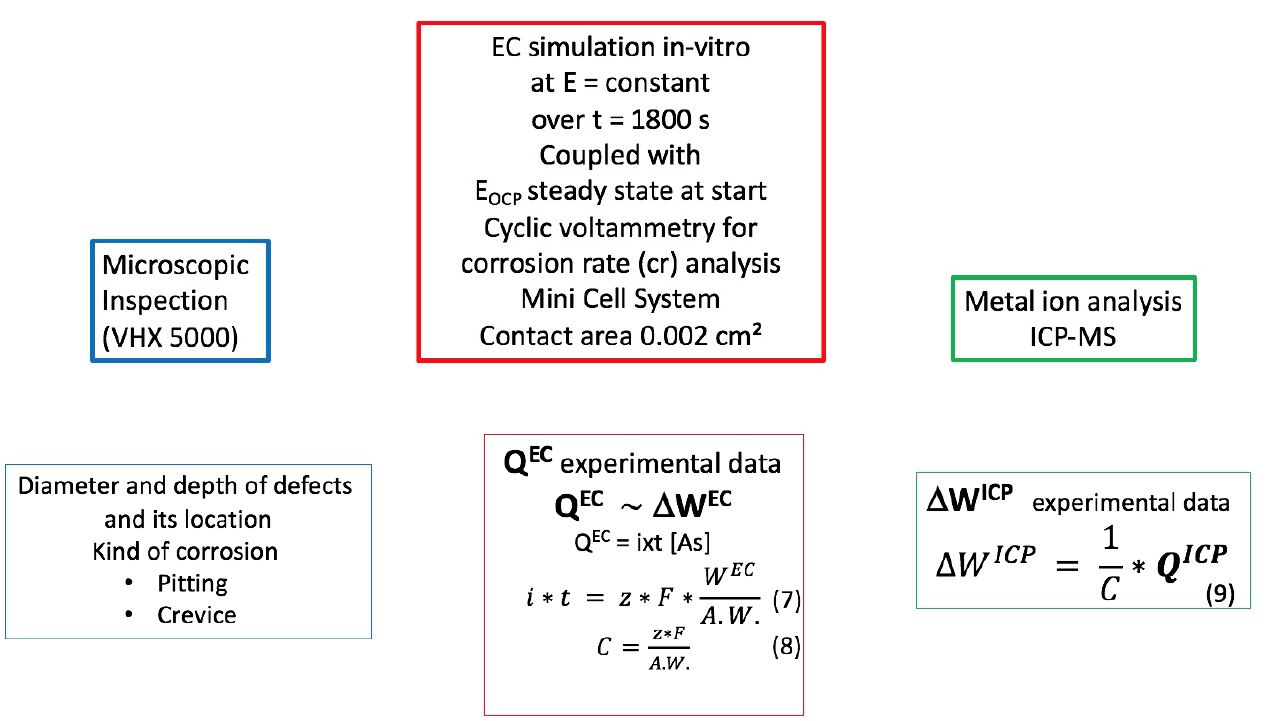
Figure 5. A schematic view of the protocol with an additional explanation of the formula of W.